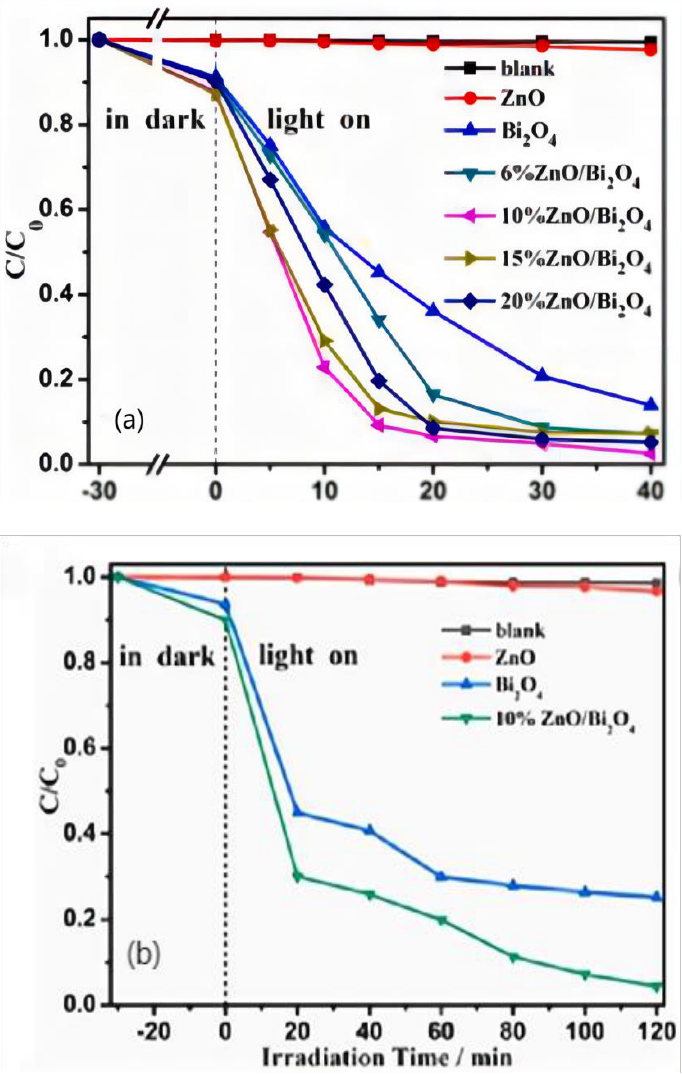
Figure 8. (a): Photocatalytic performances of the samples for degradation of CIP; Figure 8. ( a ): Photocatalytic performances of the samples for degradation of CIP; ( b ): Photocatalytic (b): Photocatalytic degradation curves of MO solution over different photocata- degradation curves of MO solution over different photocatalysts under visible light lysts under visible light irradiation;